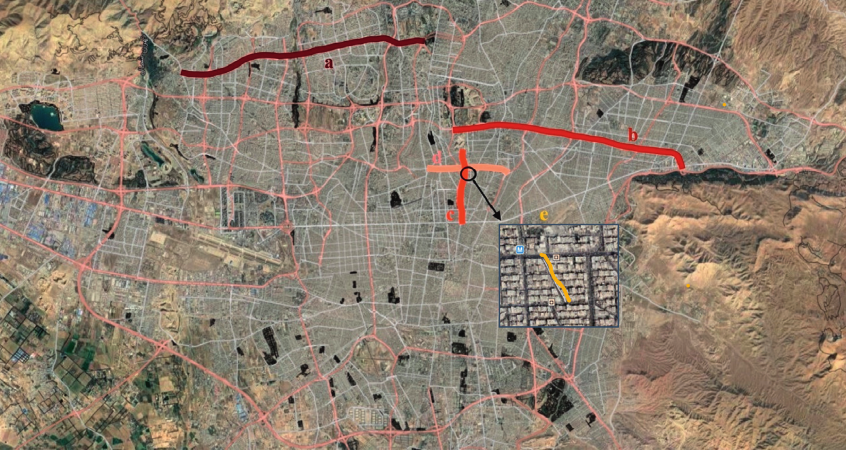
Figure 2: Location of case studies-Tehran Trafficþ Maps (https://map.tehran.ir).